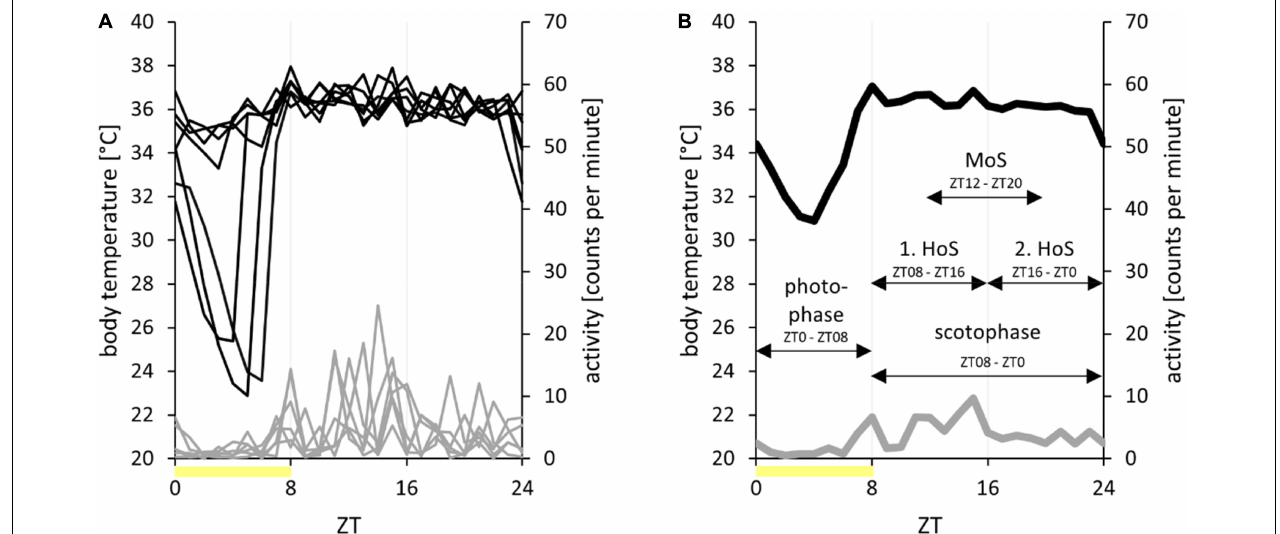
FIGURE 2 | Processing of radiotelemetry data II. Data of body temperature (in degree Celsius, black ) and activity (in counts per minute, gray ) of hamster EH02-27 over the course of 1 week in the short photoperiod (L/D, 8:16 h) with the photophases indicated as yellow bars . (A) Overlay. The data of each of the 7 days of the analysis week are overlaid for visualization on an x -axis from zeitgeber time 0 (ZT0) to ZT24. (B) Time frames. The data were averaged per ZT and week to visualize the body temperature and activity patterns of hamster EH02-27 over 1 week. In this study, the data were averaged per time frame and week ( arrows ). The time frames photophase, scotophase, first half of scotophase ( 1. HoS ), second half of scotophase ( 2 . HoS ), and middle of scotophase ( MoS ) were used. Please note that the mean values per time frame and their standard deviations have been directly calculated from the raw dataset, on which the analysis of torpor parameters was also